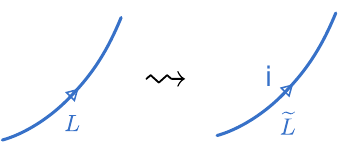
Figure 14 . The direct lift of a segment of L to sheet i of the covering f M .